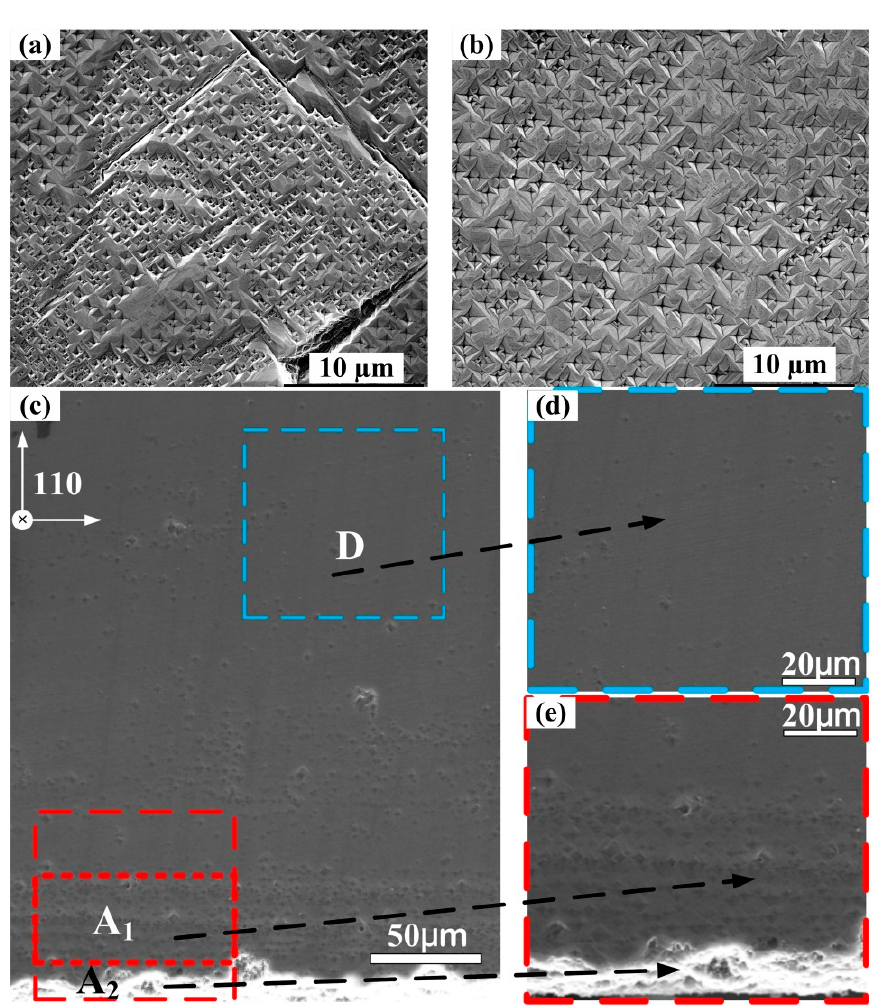
Figure 5. Etching pits of the heteroepitaxial diamond along [001] direction ( a ) at diamond/Ir inter- face and ( b ) at the surface of diamond thick film; Etching pits of heteroepitaxial diamond cross- sections along [220] direction ( c ) the film bulk distributions. ( d ) the magnification at diamond/Ir interface. ( e ) the magnification near film surface. (A 1 : at the diamond/Ir interface. A 2 : 20 µm above diamond/Ir interface; D: 200 µm above diamond/Ir interface).